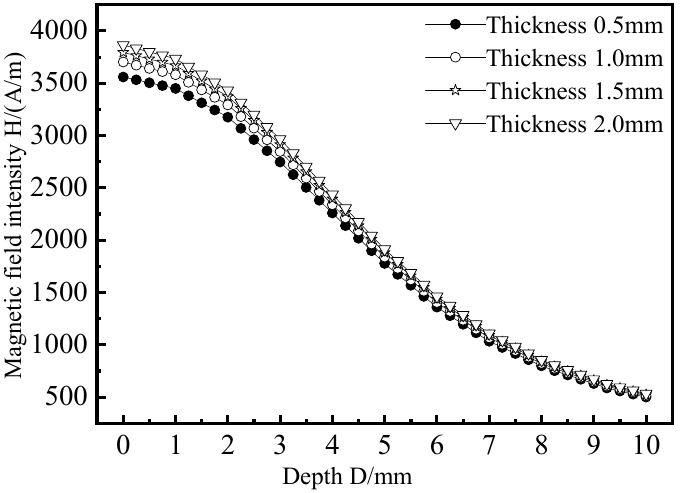
Figure 9. The influence of magnetic circuit thickness on indirectly coupled magnetic field.